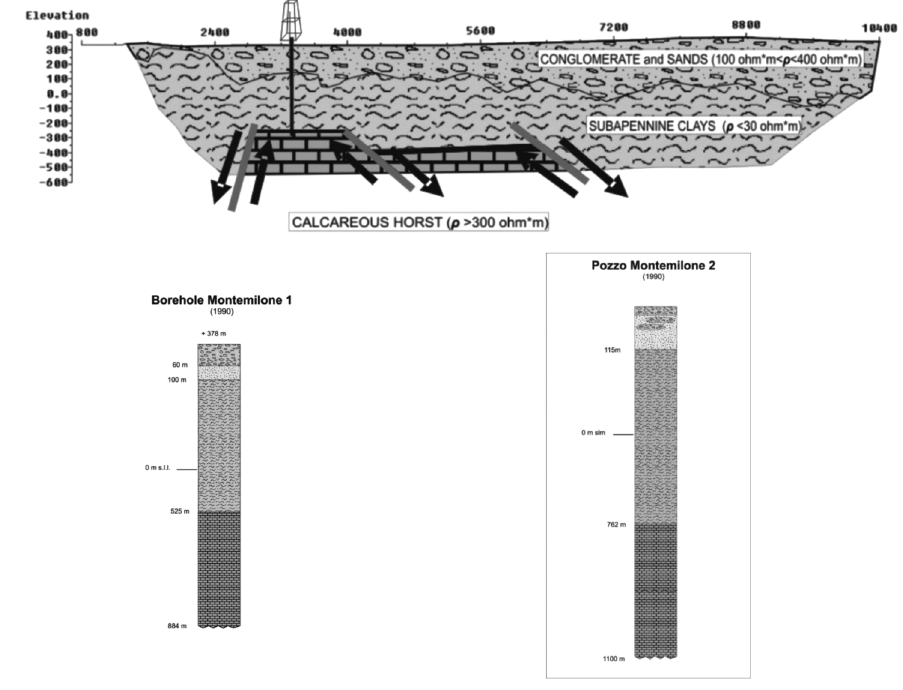
Fig. 4. Geological interpretation interpreted from deep electrical image, shallow MT model and well strati- graphical data of the Montemilone 1 and 2 wells, located at E of investigated